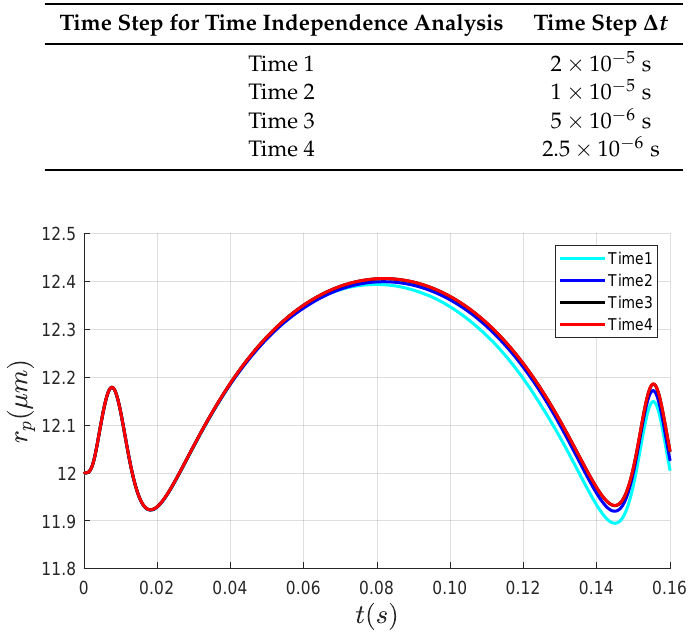
Figure A3. Time independence analysis for a particle’s radial migration as a function of time for AR = 4, r p 0 = 12 µ m, 18,571 Domain Elements, and 152 Particle Surface Elements. The lines for Time 2, Time 3, and Time 4 are very close, which shows that Time 2 still has a reasonable accuracy and a time efficient computation compared to Time 3 and Time 4.